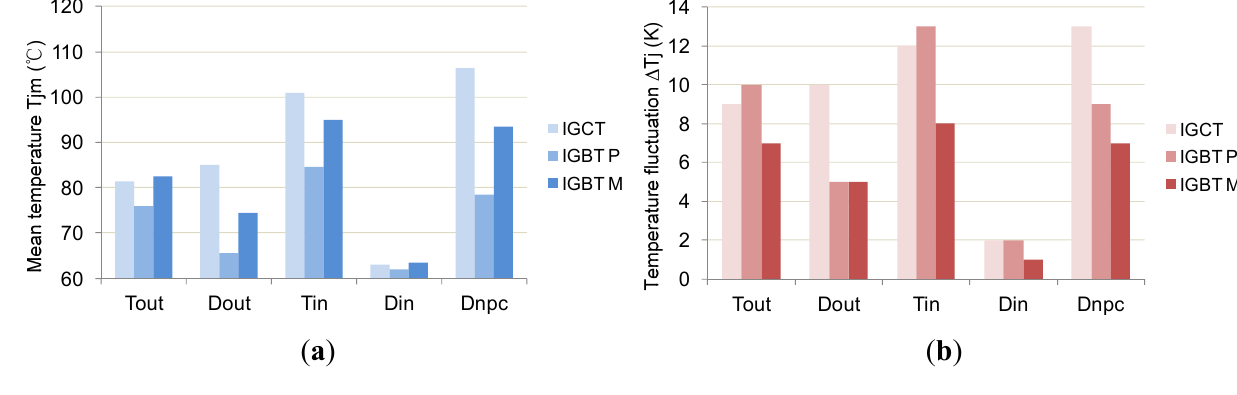
= 0.05 p.u., 100% rated reactive g and ( b ) Junction temperature fluctuation Δ T jm j